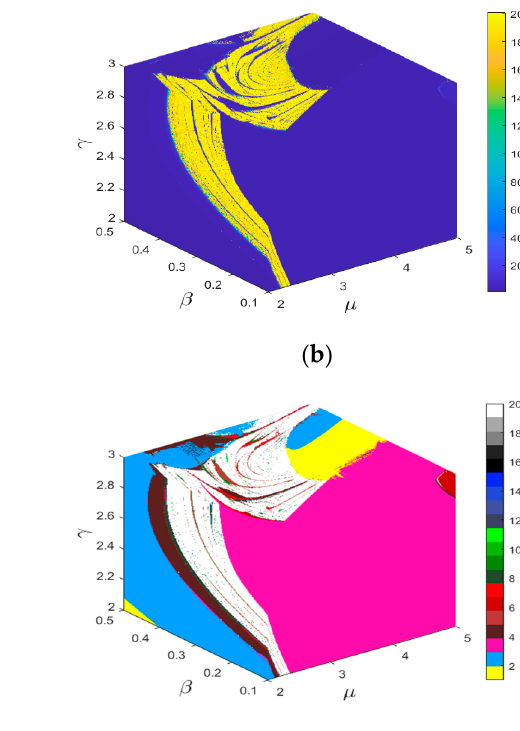
( f ) model 2 Figure 7. Plane screenshot of three-parameter bifurcation diagram: ( a )